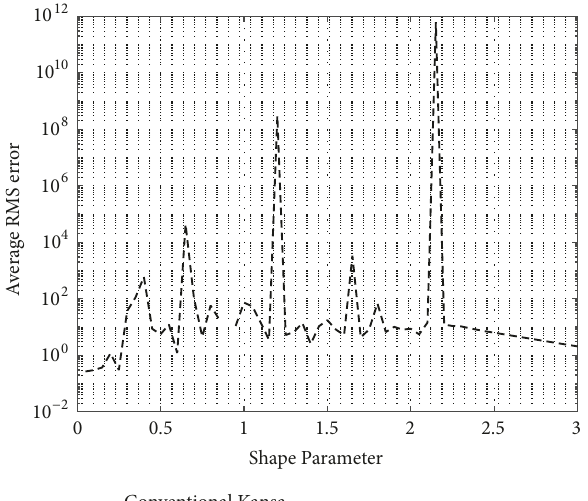
Figure 7: Average 𝐿 𝑟𝑚𝑠 -error obtained from using Kansa collocation scheme at Re = 1,000 with 𝑡 = 0.5, Δ𝑡 = 0.005 , and 𝑁 = 10 × 10 .